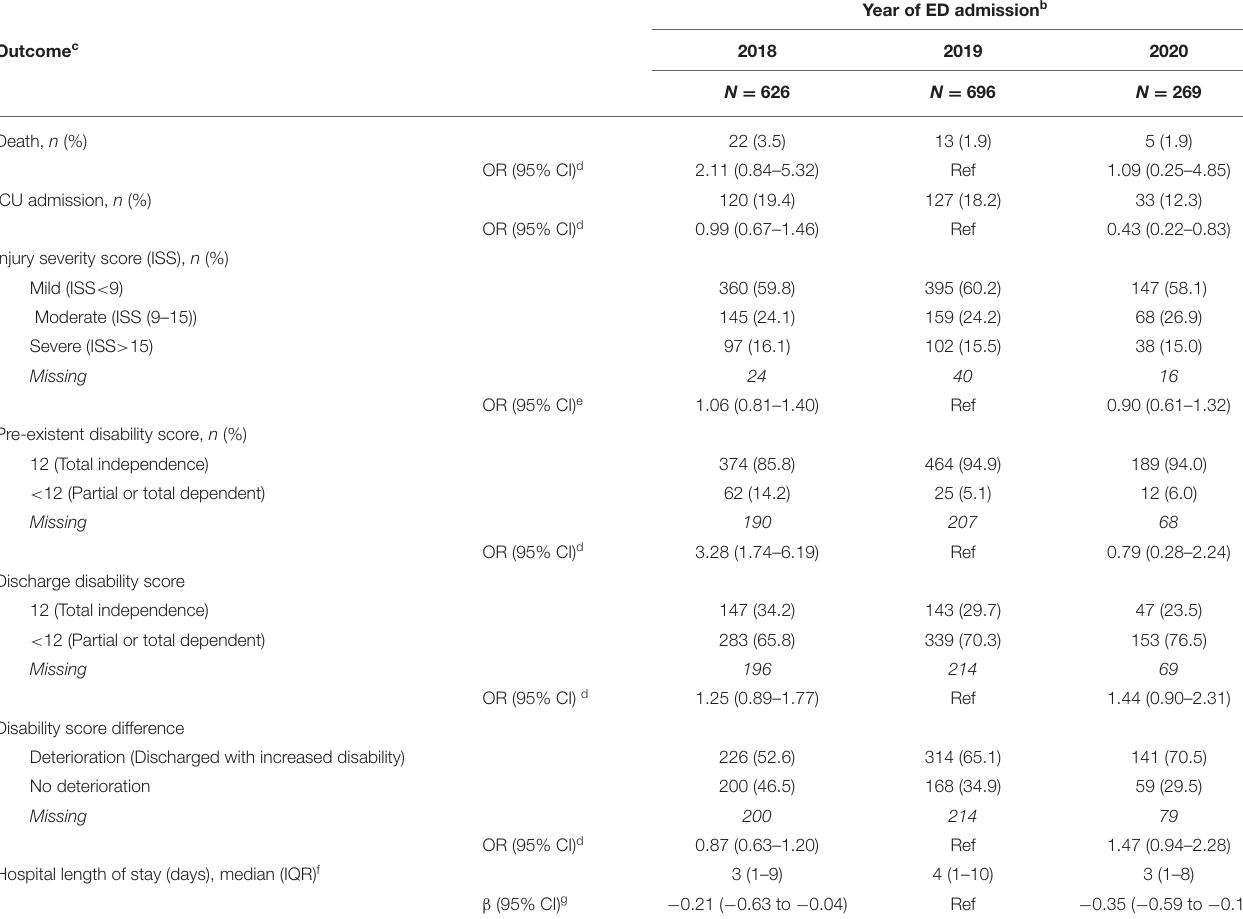
TABLE 3 | Outcomes: Death, ICU admission, injury severity, disability and hospital length of stay a